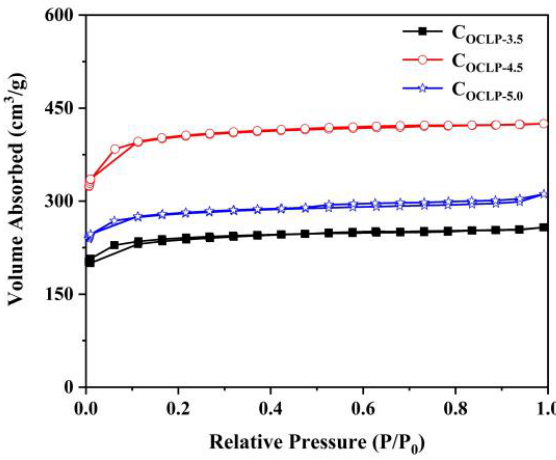
Figure 6. N 2 desorption/adsorption isotherm curves of C OCLPs . Table 1. Channel structure parameters of the C OCLPs .